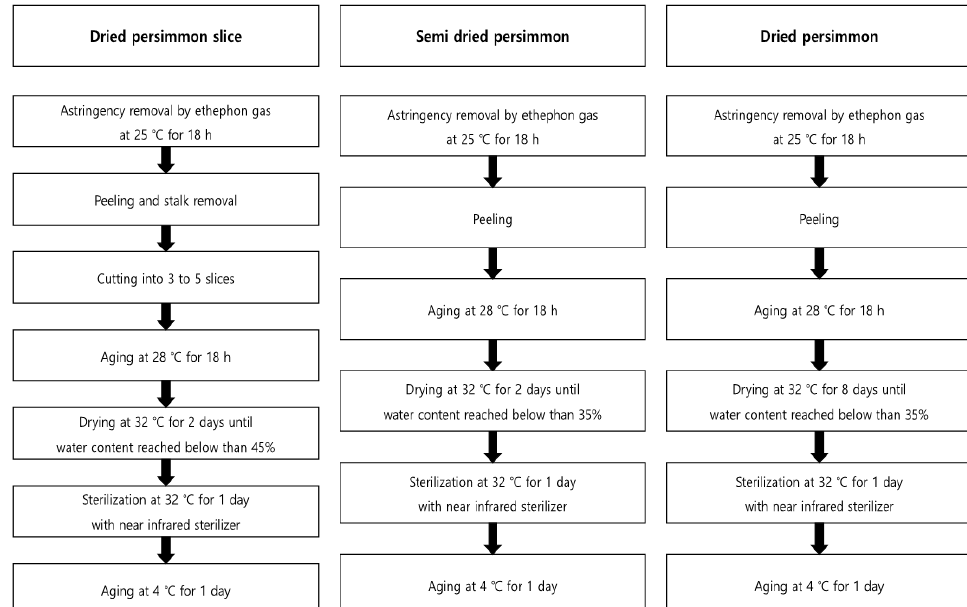
Figure 1. Manufacturing process of persimmon products.